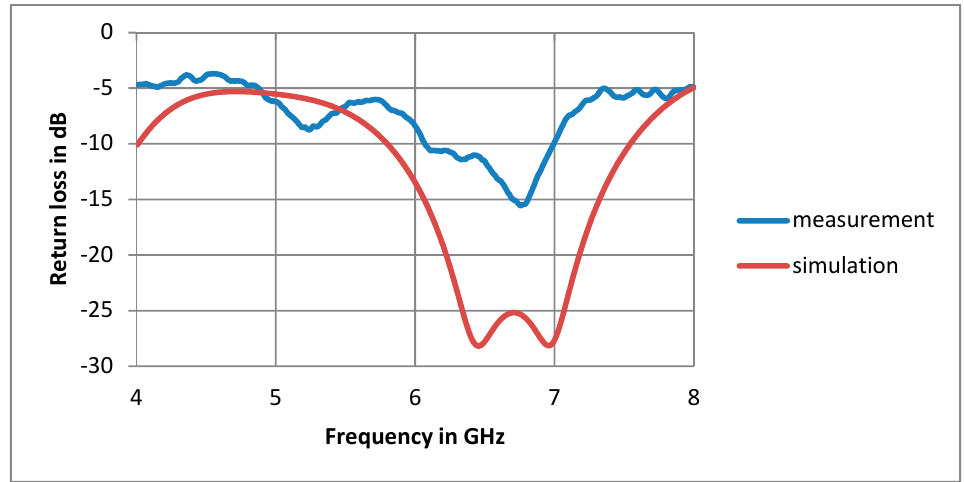
Figure 14. The simulated and measured return losses of the slot antenna (thickness = 1.27 mm).